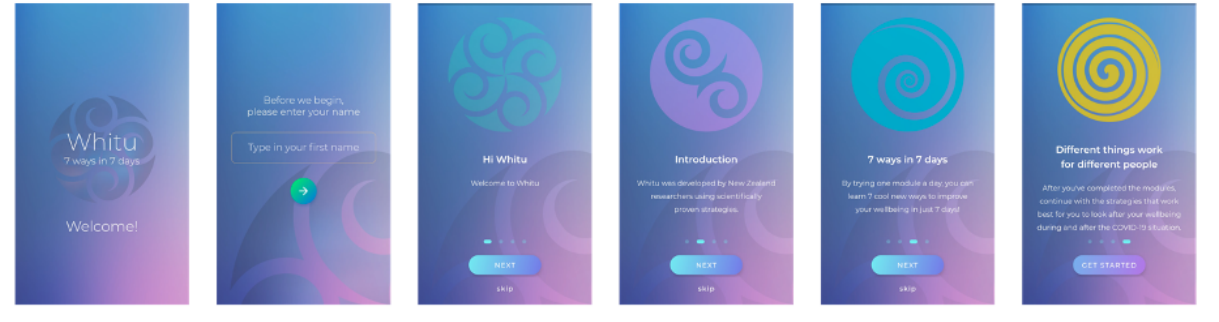
Badges Users earn badges as they complete modules and revision exercises. The aesthetics of the badges are inspired by M ā ori and Pacific design motifs. Earned badges will appear in color on the Badges screen, while unearned badges appear greyed out. Users can collect a total of 20